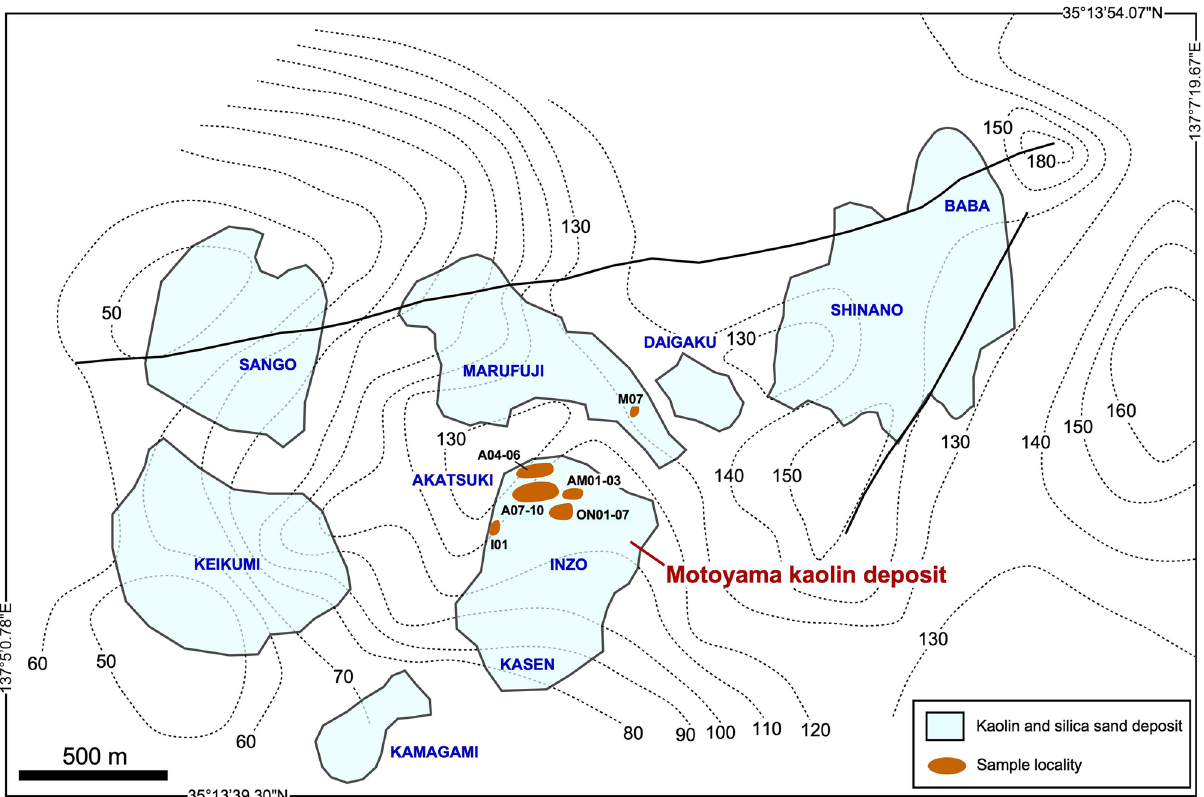
Figure 2. Distribution of kaolin and silica sand deposits in the Seto area and sample localities, based on aerial photographs of the Geospatial Information Authority of Japan and the personal communication with mining companies. The altitude (dotted lines, meter above the sea level) of basement granite beneath the Seto porcelain clay formation was drawn after Ref. 10